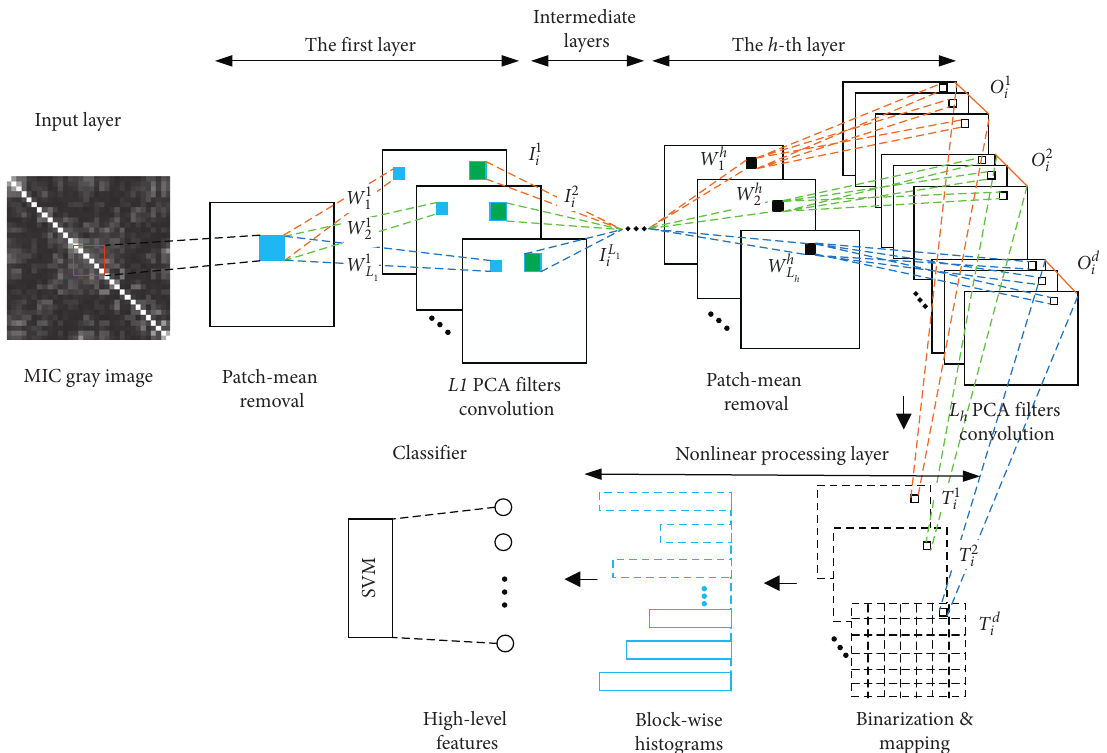
Figure 5: PCA network-based deep learning model structured from a simple deep architecture for emotion recognition. The model consists of PCA convolution layers and a nonlinear processing layer to learn high-level features from MIC gray